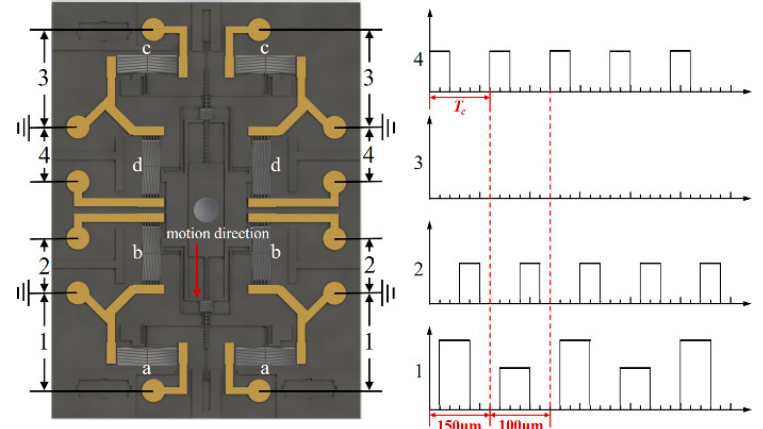
Figure 8. The driven signal of the pawls on the chip.